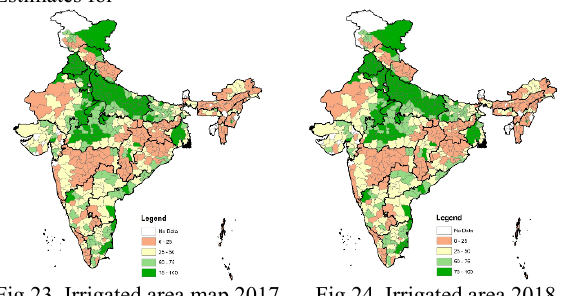
Fig 23. Irrigated area map 2017 Fig 24. Irrigated area